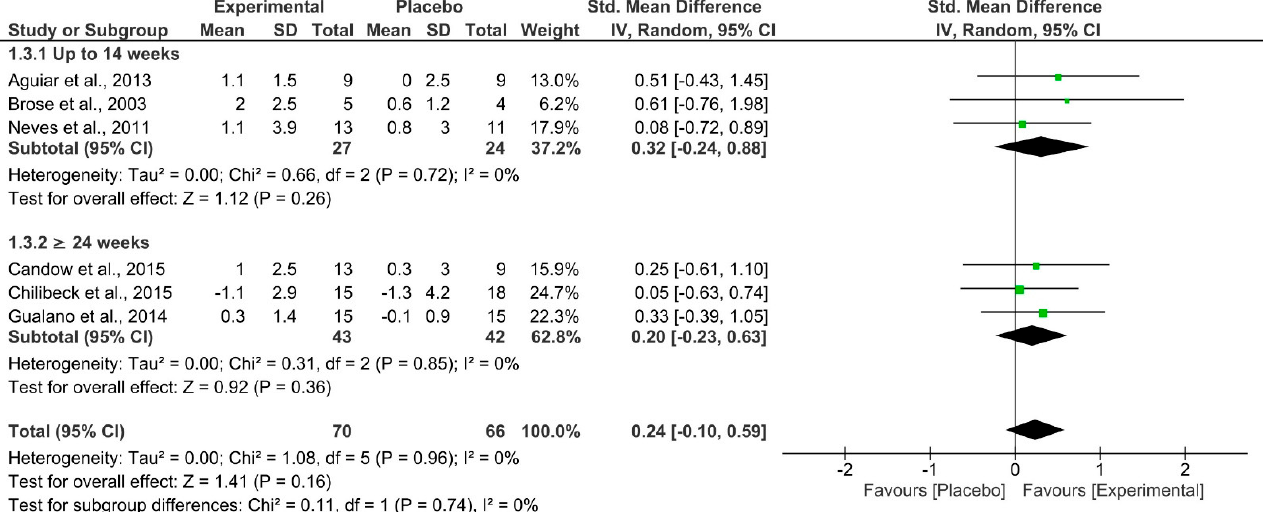
Figure 4. Forest plot for muscle mass, separated by subgroups according to study duration (up to 14 weeks and ≥ 24 weeks).